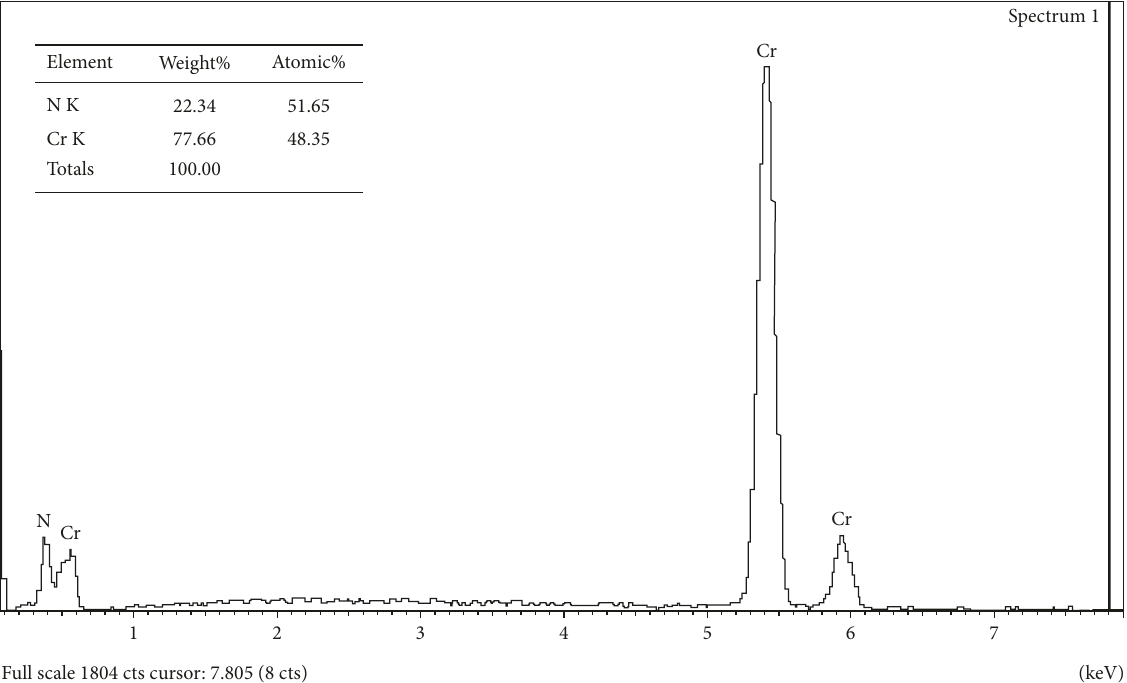
Figure 11: The EDS analysis of CrN coating from area shown in Figure 9.